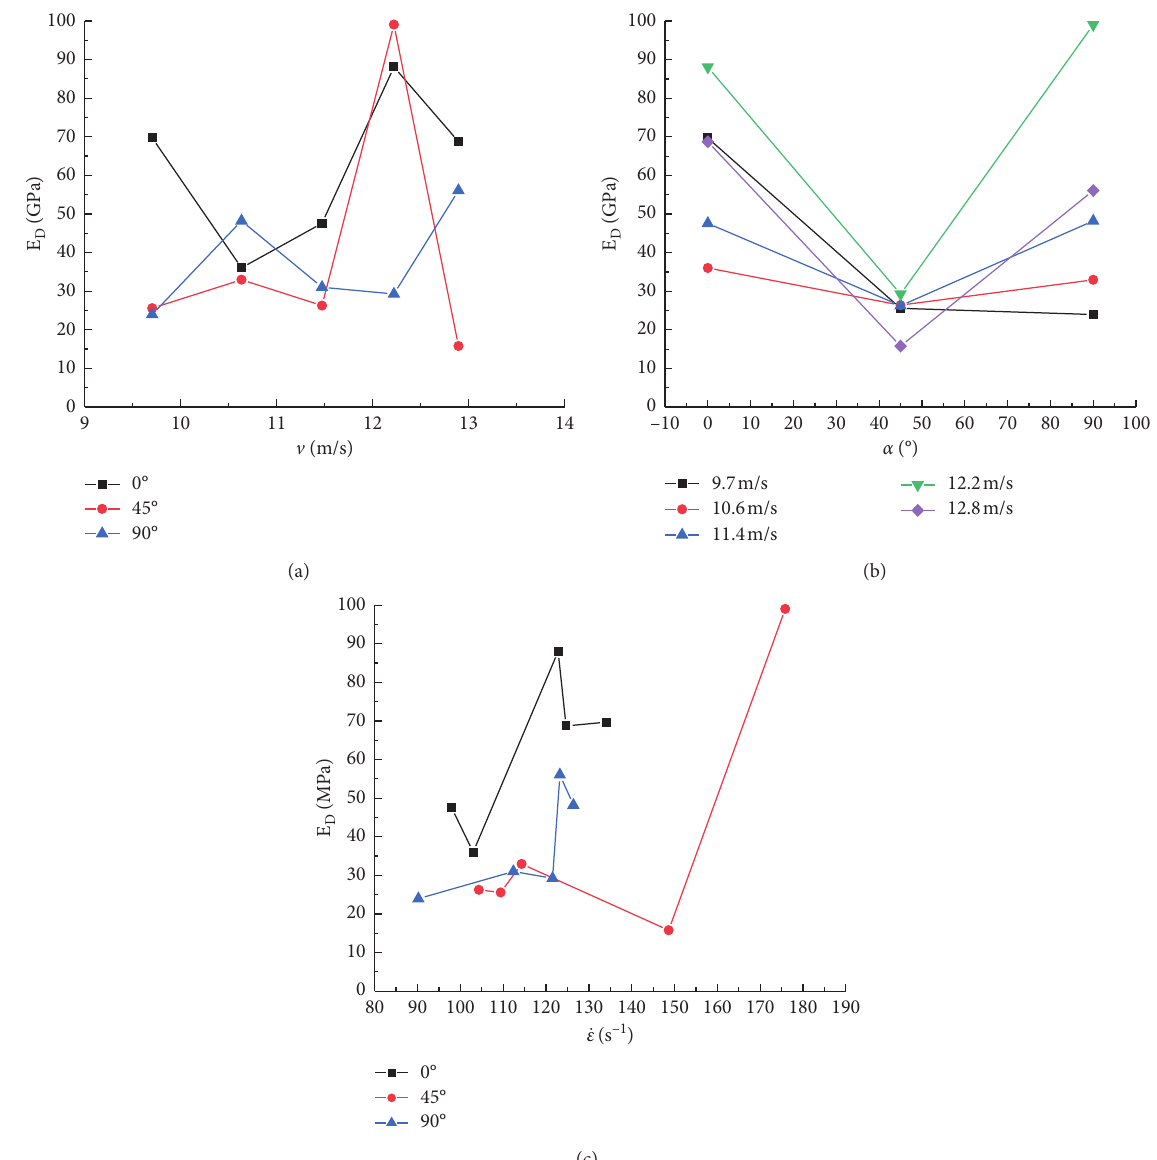
Figure 9: Relationship curves between dynamic elastic modulus and loading rate, prefabricated fracture angle, and strain